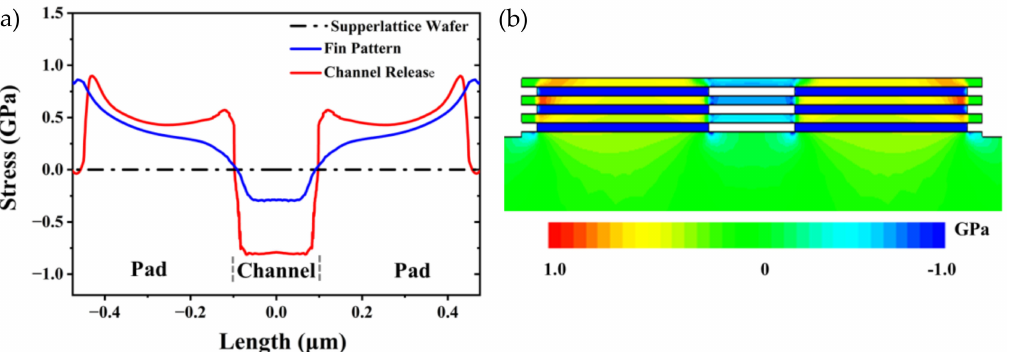
Figure 2. ( a ) Calculated stress values along the Si channel direction in the middle of the Si/SiGe multilayer structure obtained by the Sentaurus simulation. ( b ) Stress distribution in the test pattern after the channel release obtained by the Sentaurus